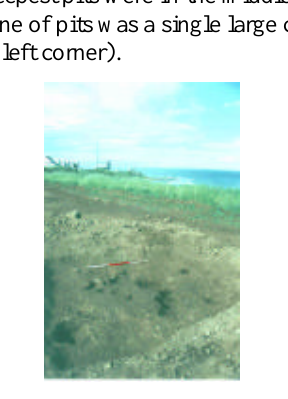
Figure 4: Showing arc of pits after removal of F46 - seen from the